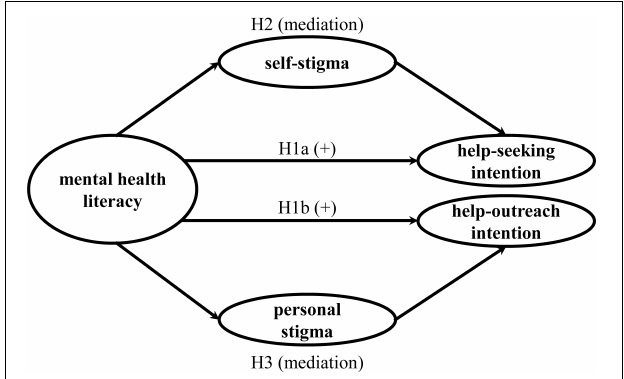
FIGURE 1 | Illustration of conceptual